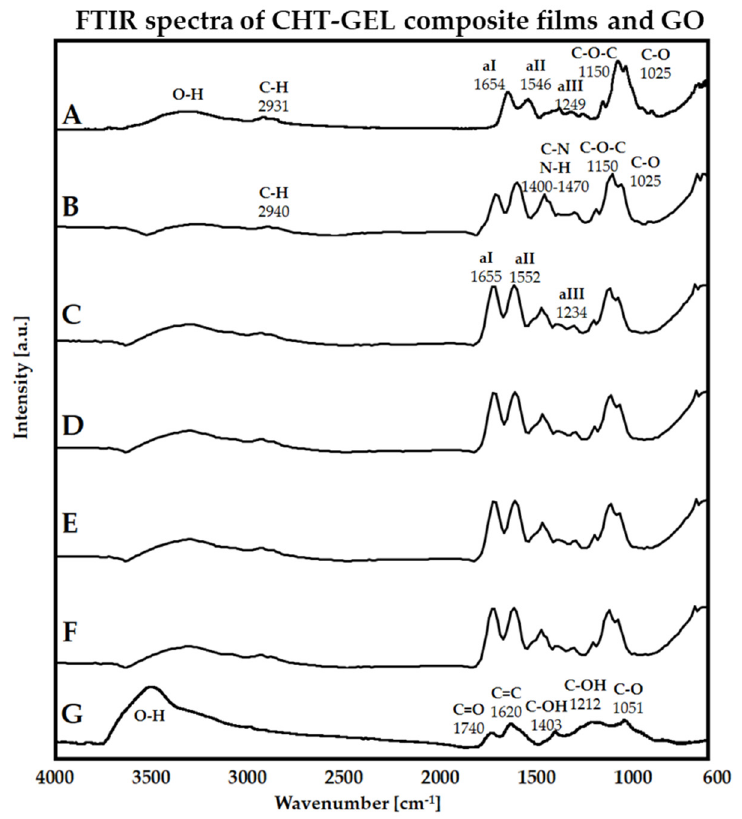
Figure 1. FTIR spectra of CHT-GEL ( A ), CHT-GEL-GEN ( B ), CHT-GEL-GEN-GO05 ( C ), CHT-GEL-GEN-GO1 ( D ), CHT-GEL-GEN-GO2 ( E ), CHT-GEL-GEN-GO3 ( F ), graphene oxide powder ( G ).